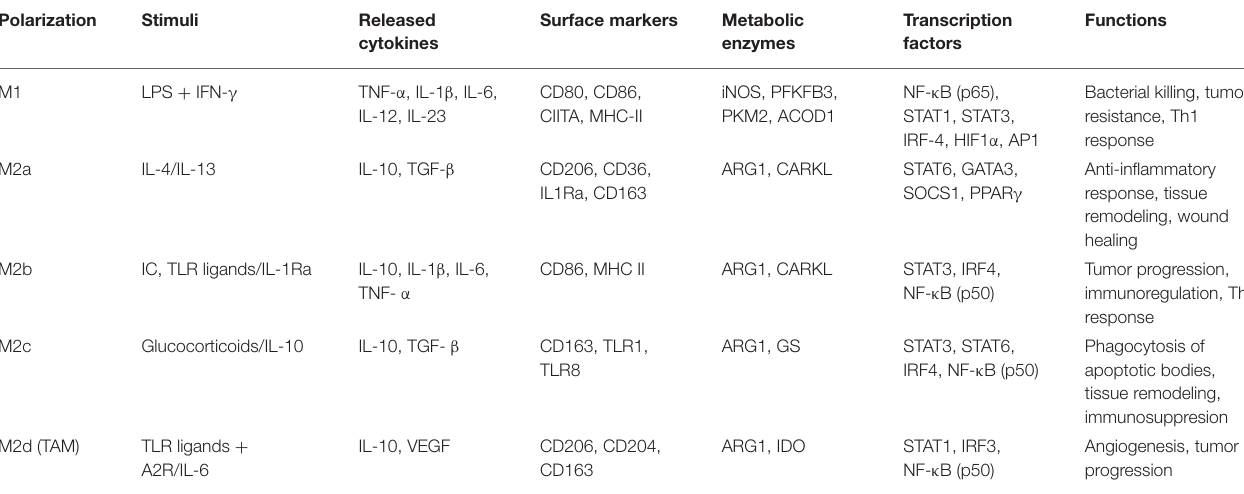
TABLE 1 | A schematic summary of macrophage polarization.